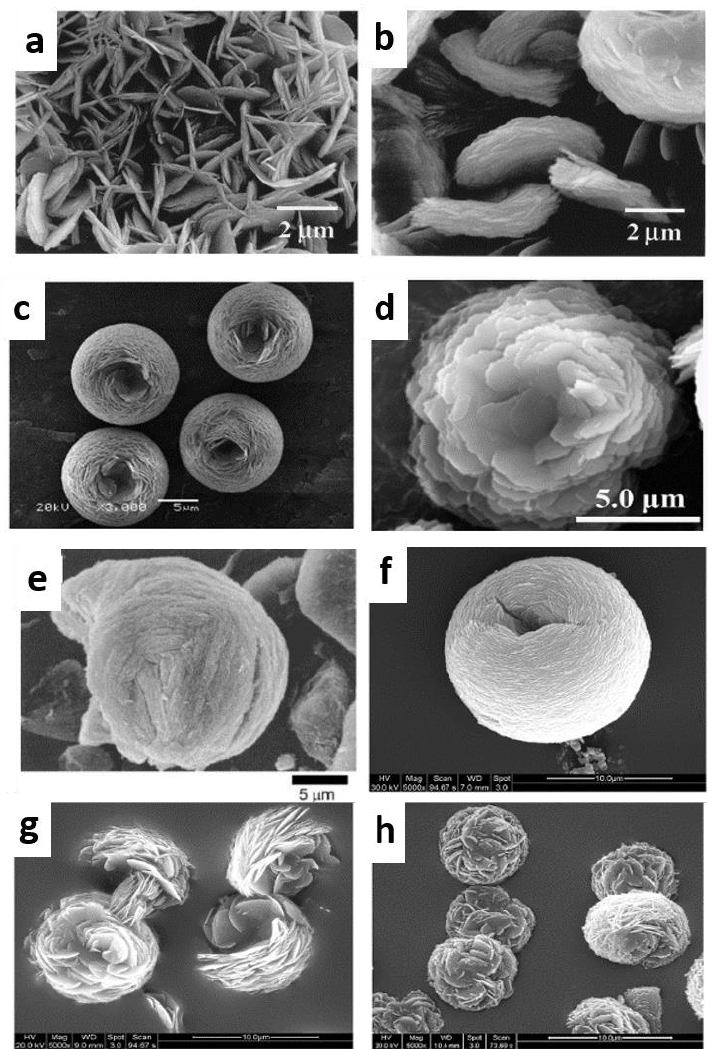
Figure 3. Morphologies of MCM-22 zeolites obtained under dynamic ( a ) and static conditions ( b – h ). The zeolites under static conditions differ in methodology, molar composition, silicon source, and temperature. Adapted from Reference